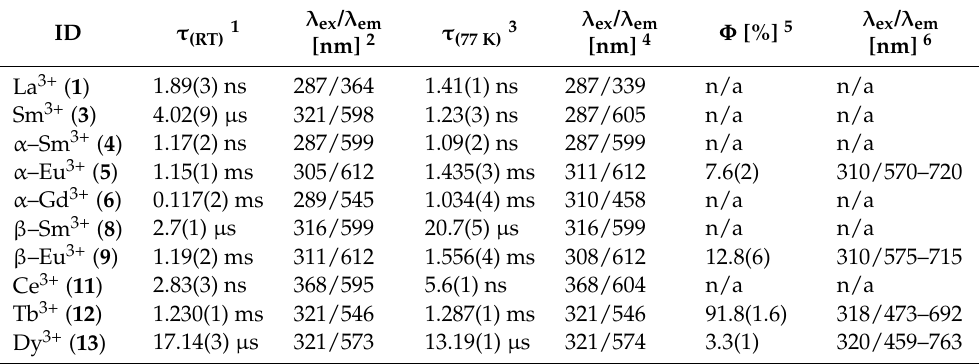
Table 2. Photophysical data of 1 ∞ [Ln 2 (2–PyPzH) 4 Cl 6 ], Ln = La ( 1 ), Sm ( 3 ), α –[Ln 2 (2–PyPzH) 4 Cl 6